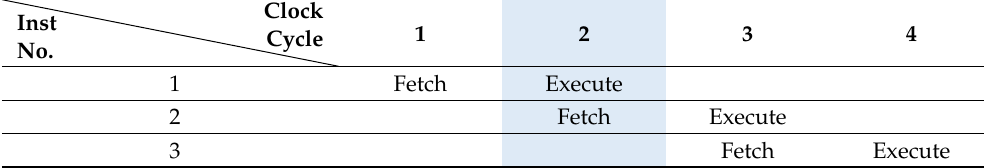
Table 2. Two-stage pipelines.